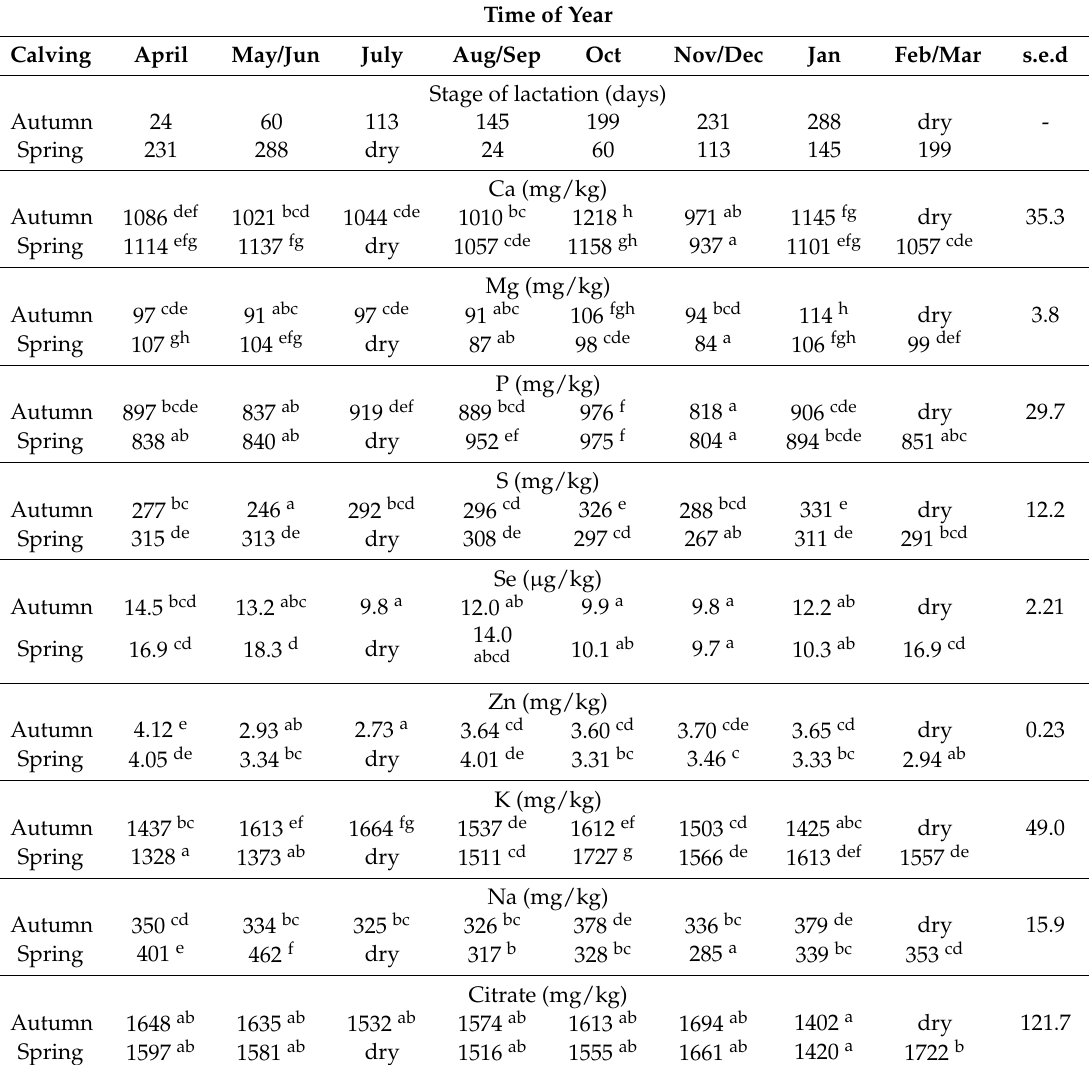
Table 4. The average concentrations of minerals and citrate in milk for herds that calved in autumn or spring by the time of year that samples were collected.